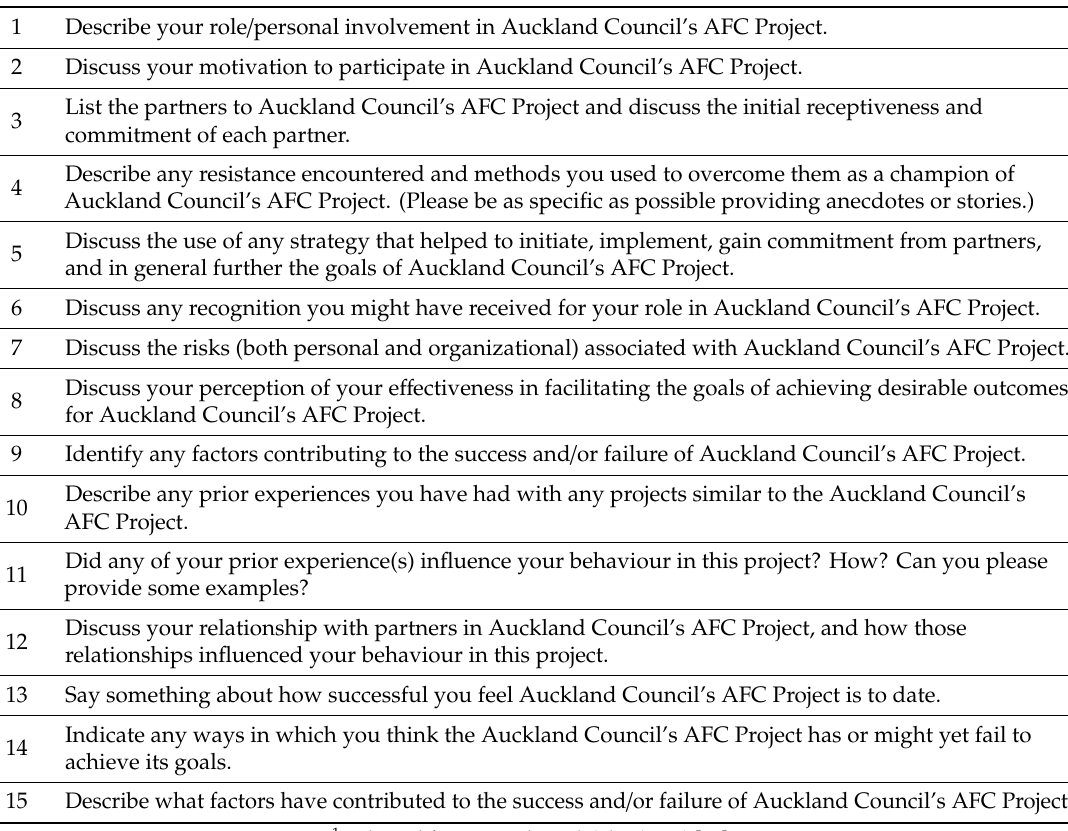
Table A1. Auckland Council’s Age-friendly City (AFC) Project interview prompts 1